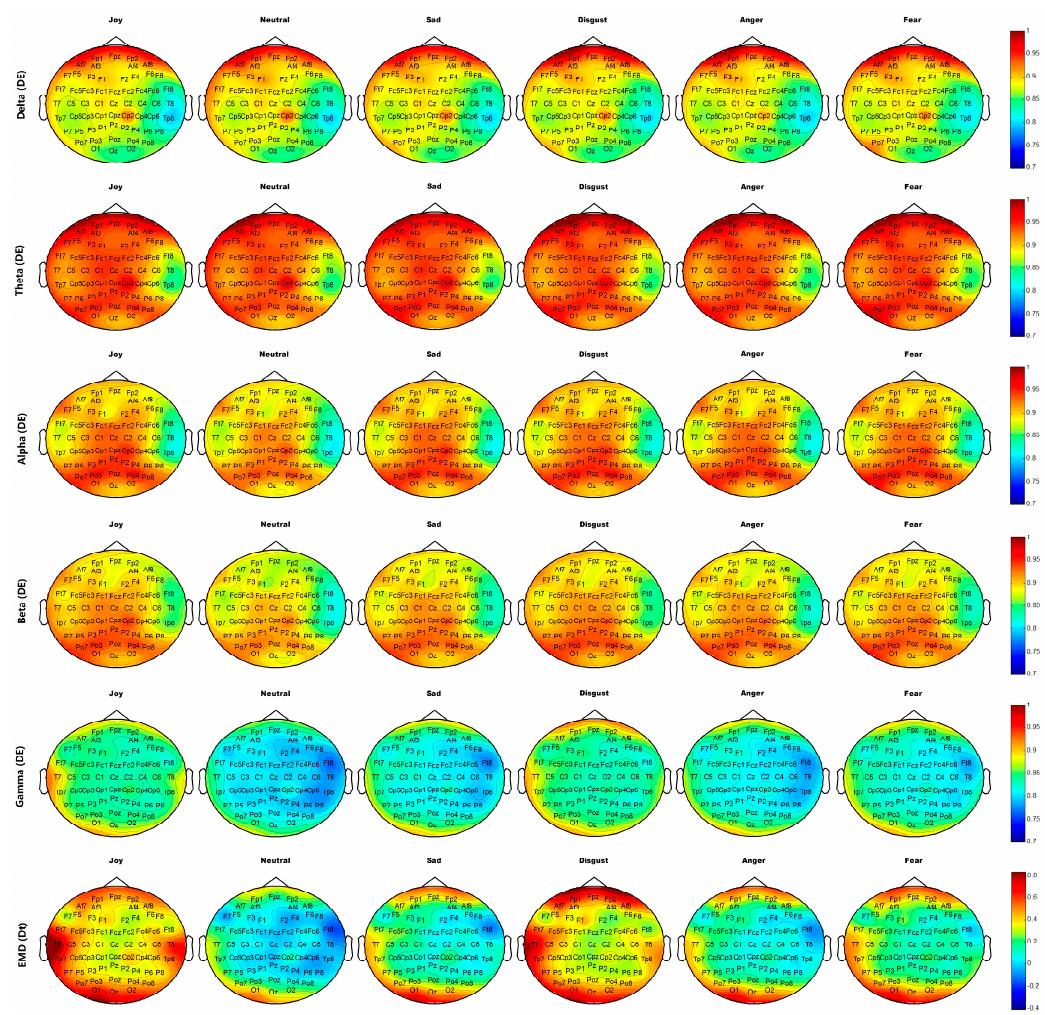
Figure 15. Average neural patterns for different self-induced emotions of all participants. DE of frequency band Delta (1–4Hz), Theta (4–8 Hz), Alpha (8–12 Hz), Beta (12–30 Hz), and Gamma (30–64 Hz) and the first difference D t of IMF1 decomposed by EMD are illustrated from top to bottom.